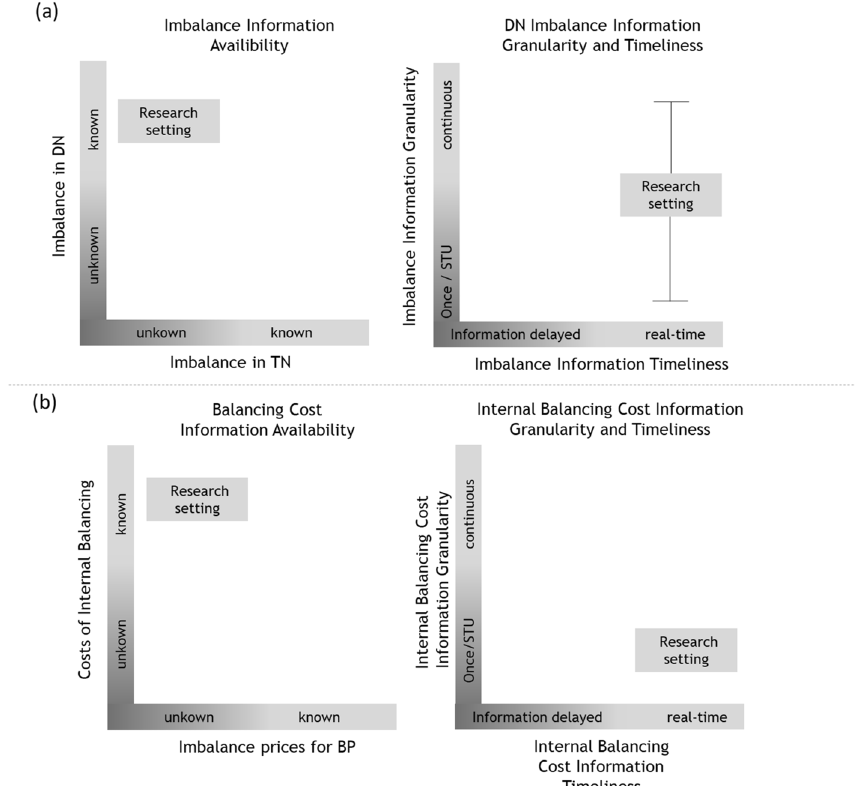
Figure 2 Research setting: Information sets (imbalance informtion (a), balancing cost (b)) at the time of